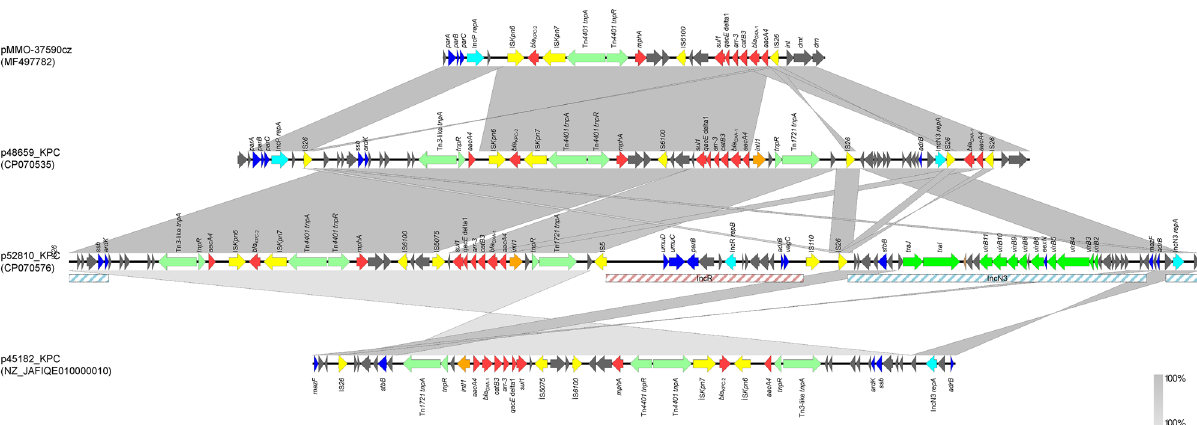
Figure 2. Linear comparisons of the KPC-encoding plasmids p48659_KPC and p45182_KPC. Arrows show the direction of transcription of open reading frames (ORFs). Resistance genes are shown in red. IS elements and transposases are shown in yellow and light green, respectively. intI1 genes are shaded purple. Genes encoding replication, stability and transfer systems are shown in aqua, blue and green colors, respectively. The remaining genes are shown in gray. Homologous segments (representing ≥ 85% sequence identity) are indicated by gray